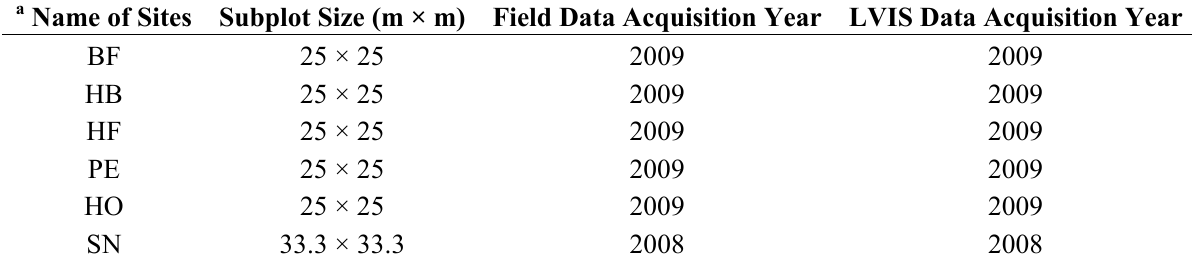
Table 1. Datasets for inter-comparisons between field measured and LVIS waveform derived heights.